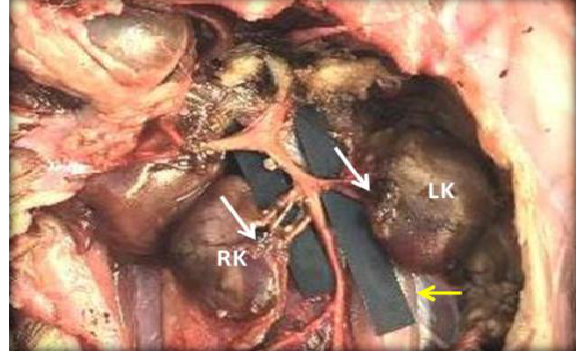
Figure, 4: Histological sagittal section of whole kidney shows: renal capsule (Rc), renal cortex (Rc), renal medulla (Rm), renal column (Rc), renal pelvis (Rp) and renal calyx (Rx). H&E stain.